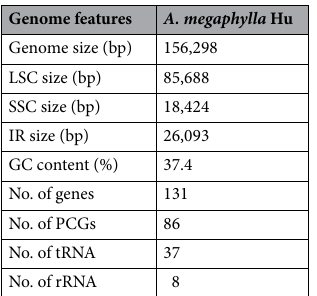
Table 1. Summary of the chloroplast genome of A. megaphylla Hu species.